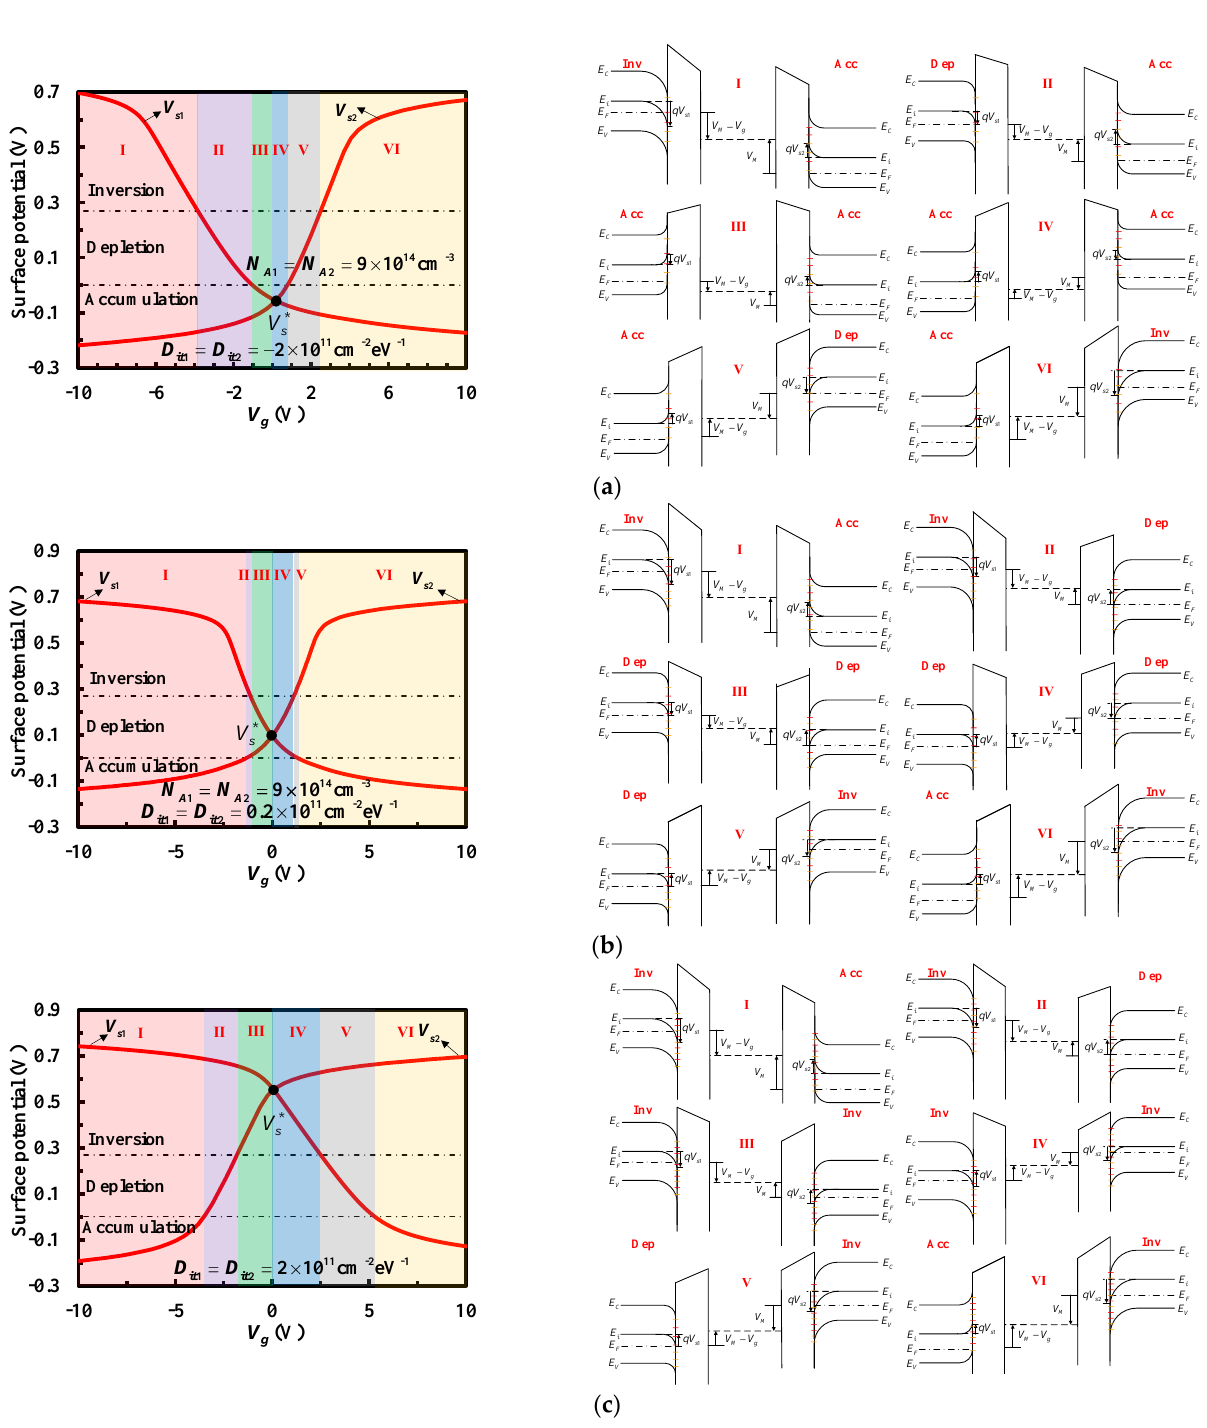
Figure 5. Surface potentials and energy-band diagrams: V s * at ( a ) accumulation, ( b ) depletion, ( c ) inversion of the staked bonding structure.